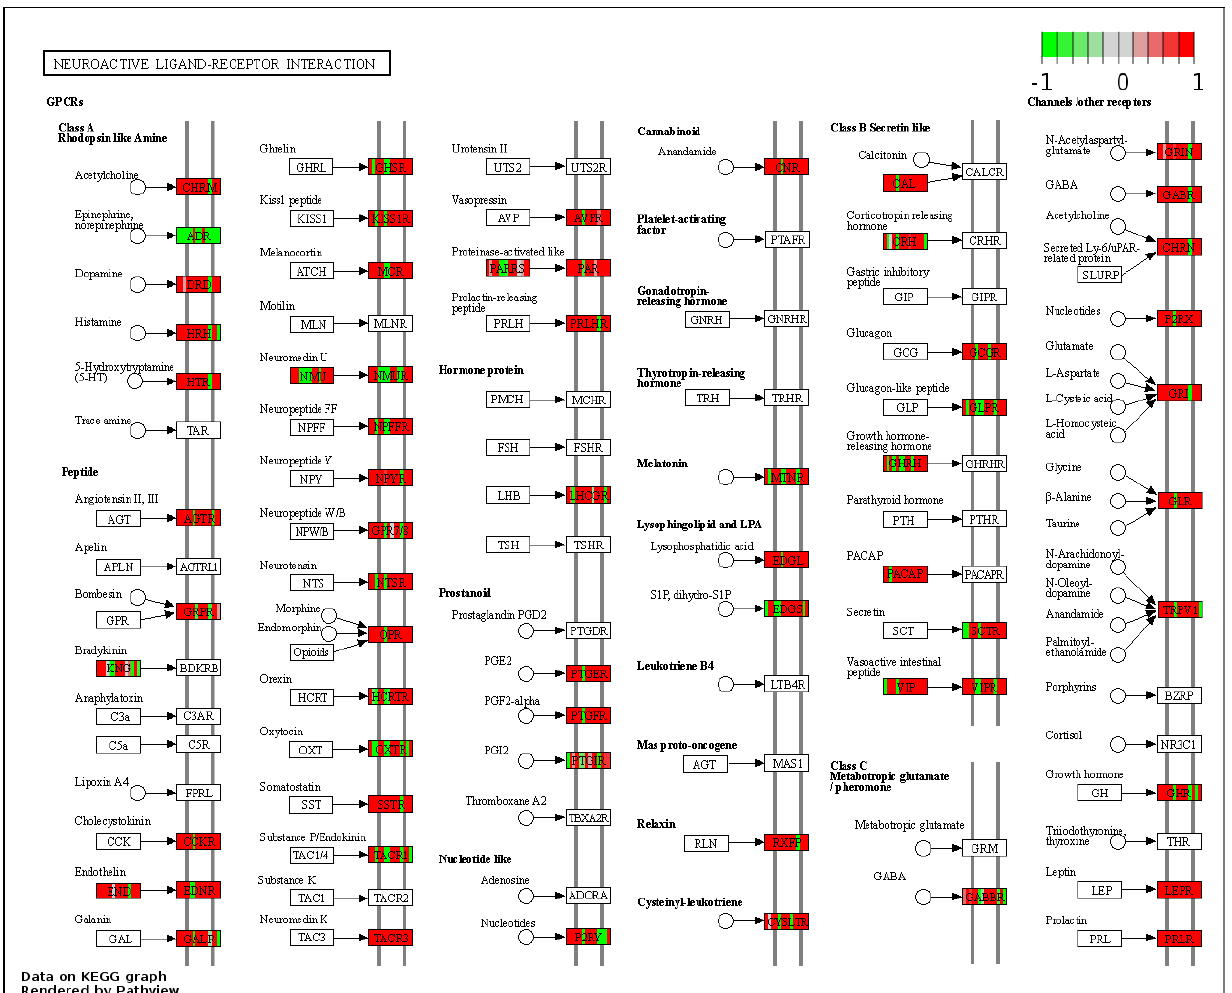
Figure 3. Kyoto Encyclopedia of Genes and Genomes (KEGG) pathway “Neuroactive ligand–receptor interaction” (RYGB vs. sham). Higher expressed genes in red, and lower expressed genes in green. Data rendered by Pathview (https://pathview.uncc.edu/, accessed on 27 December 2021).